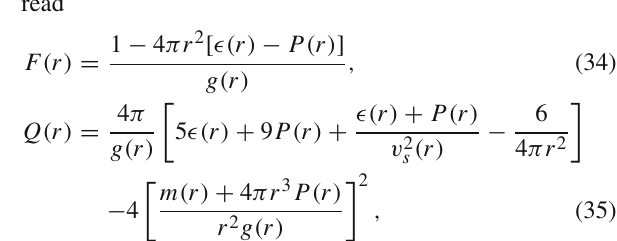
deformed when subjected to an external gravitational field.